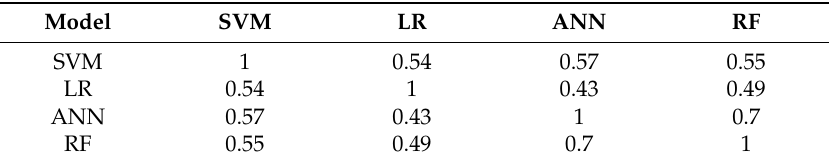
Table 4. The consistency among the accuracies of the